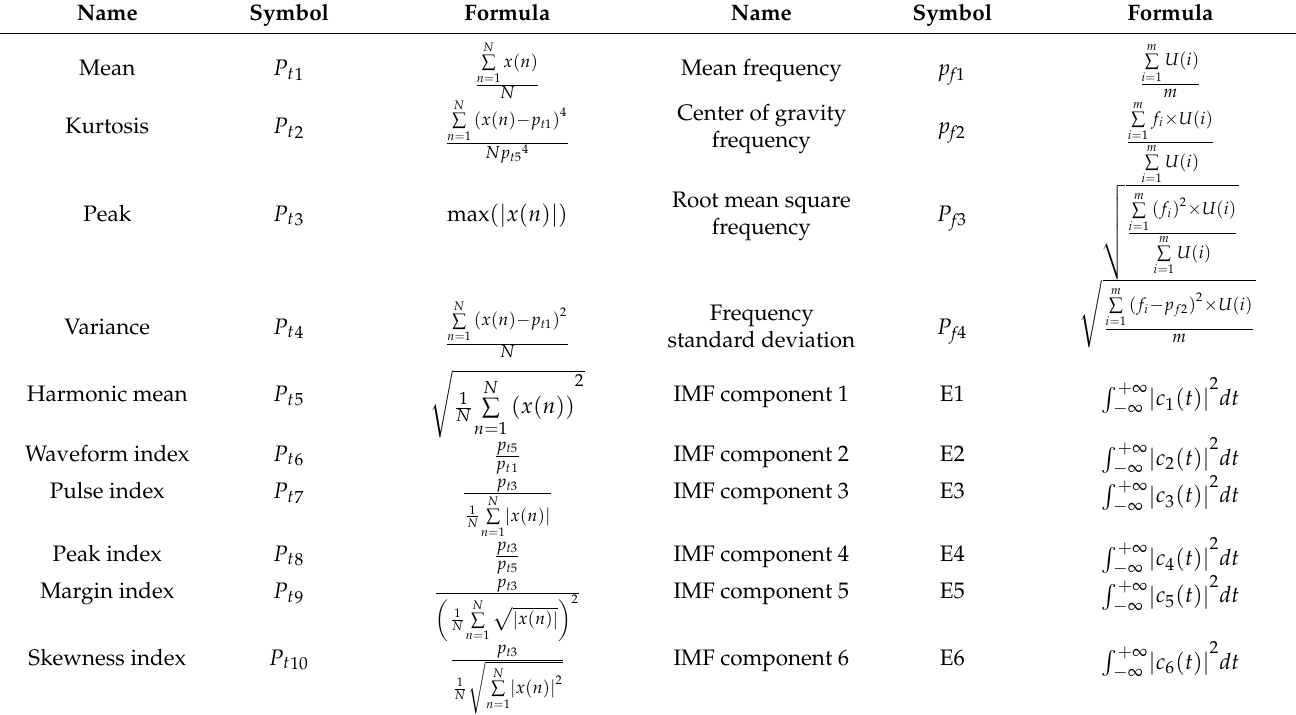
Table 3. Signal characteristic index information